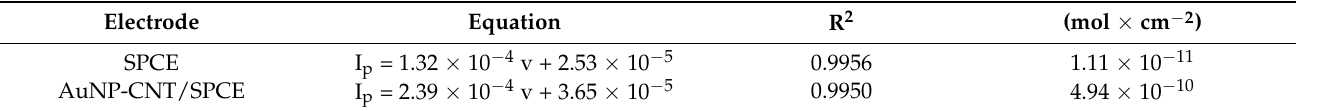
Table 3. Equation of the linear regression I p vs. v, R 2 and Г corresponding to the two sensors. Electrode Equation R 2 (mol × cm − 2 ) SPCE